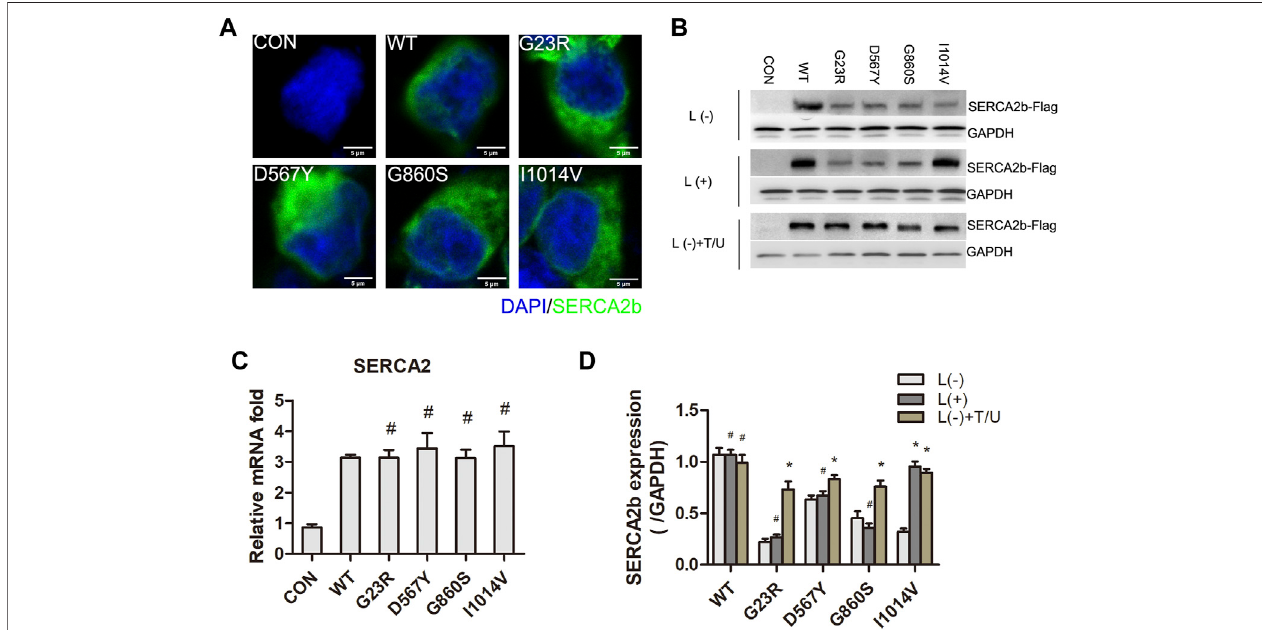
FIGURE 3 | LOF of SERCA2 is caused by insoluble and low-expression of mutants protein. A- B: Intracellular distribution and expression of SERCA2 in mutant cells. Anti-Flag antibody was used to detect the expression of WT and mutant proteins by immunostaining (A) and Western Blotting (B) . L: lactacystin, T/U: Cells were treatedwithanadditional1%Triton-X100andultrasonicfragmentation.Scalebar,5 µm. (C) :ExpressionlevelofSERCA2mRNAbyqPCR. # p > 0.05comparedwithWT group, respectively. (D) :Quanti fi cation of SERCA2 protein level with or without lactacystin and T/U treatment. * p < 0.05 compared with L (-)treatmentcells in each groups, # p > 0.05 compared with L (-) treatment cells in each groups,